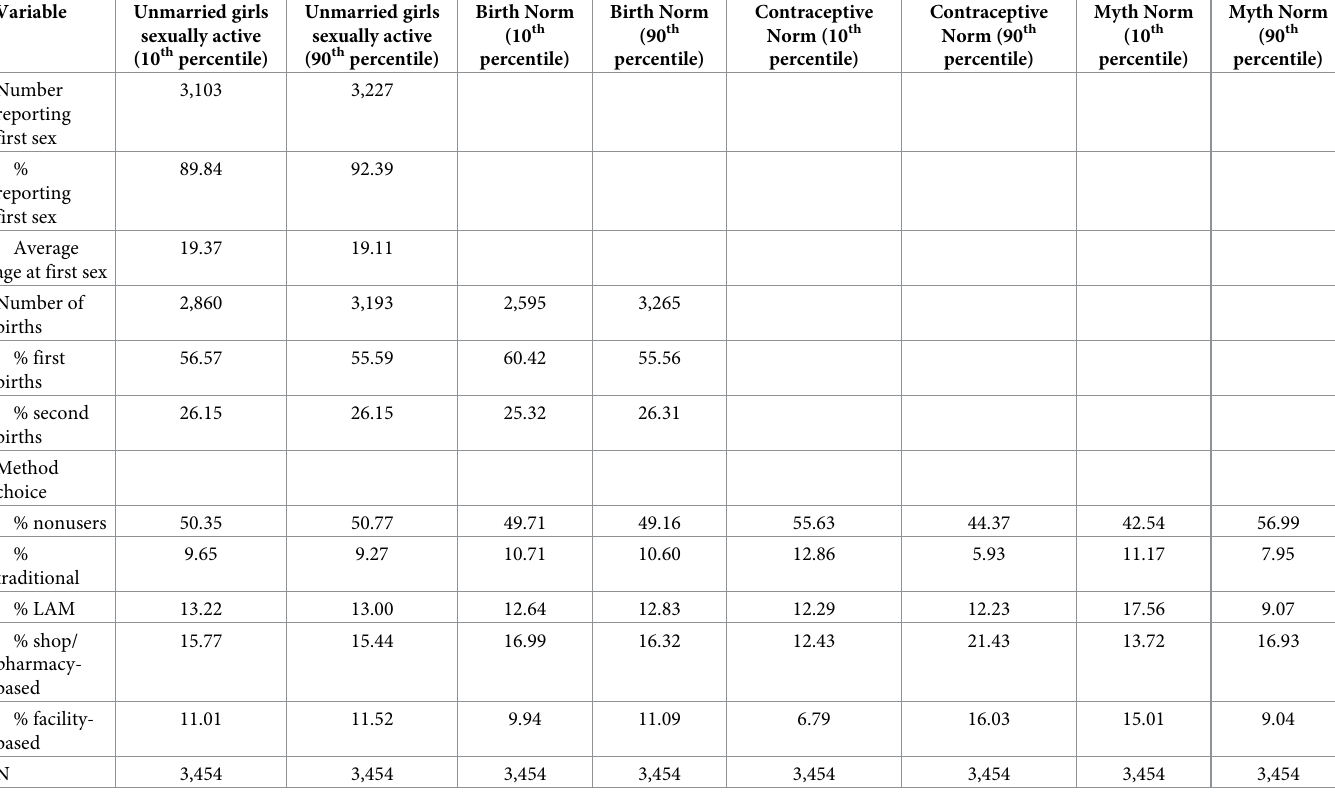
Table 6. Direct and indirect effects of community beliefs on outcomes (corrected results).